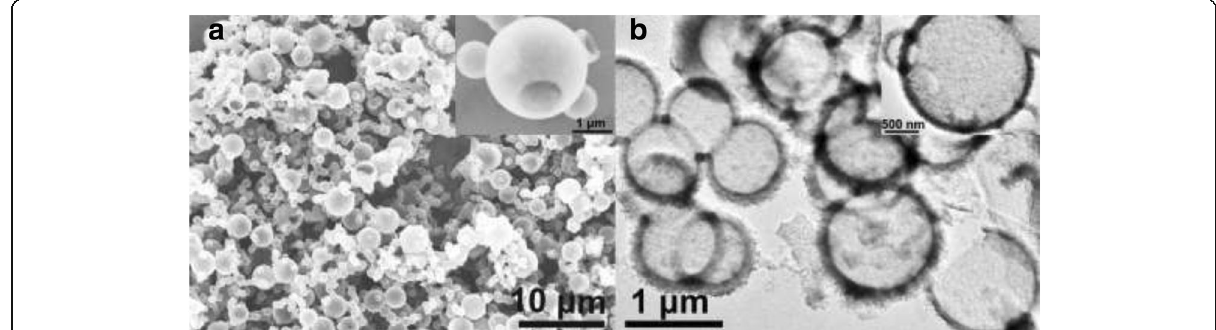
Fig. 1 a SEM and b TEM images of the as-synthesized hollow PANI